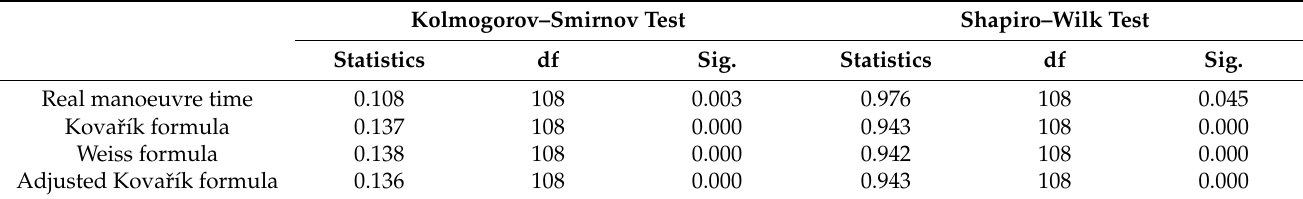
Table 4. Kolmogorov–Smirnov test results.